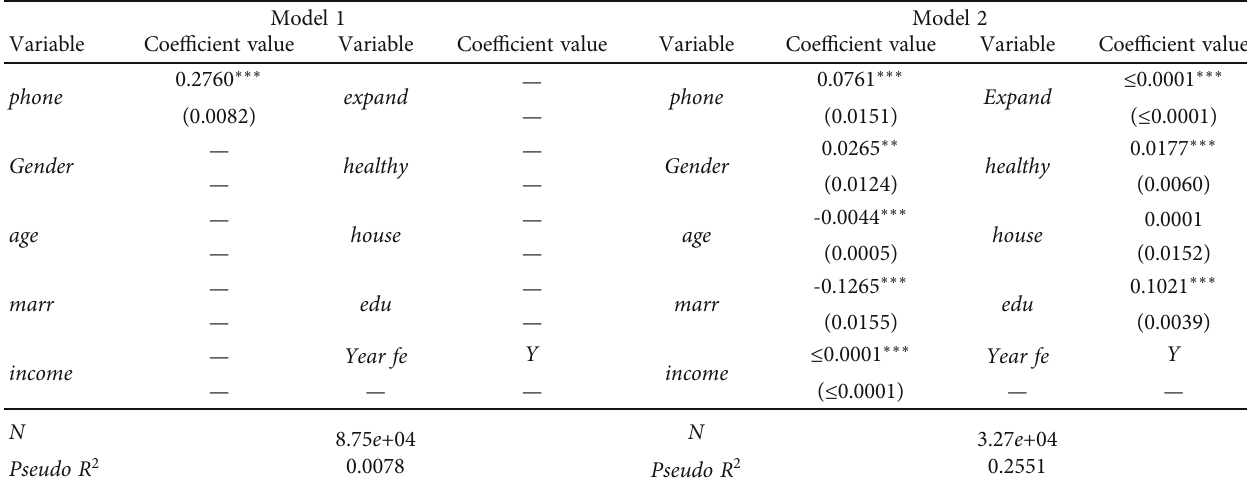
Table 4: O-probit model results of digital life and resident